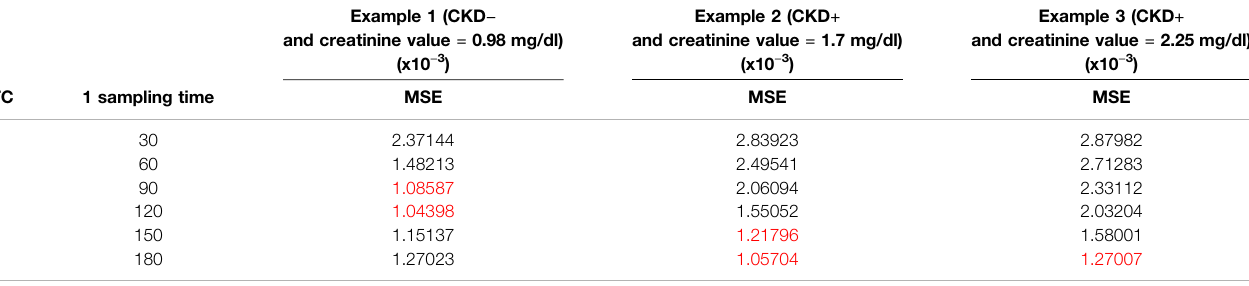
TABLE 3 | Mean square error for the time combination K (MSE K ) results of optimal designs including 1 sample (TC: time combination). The best sampling times for each example of dogs are in red. Example 1 (CKD − and creatinine value = 0.98 mg/dl)